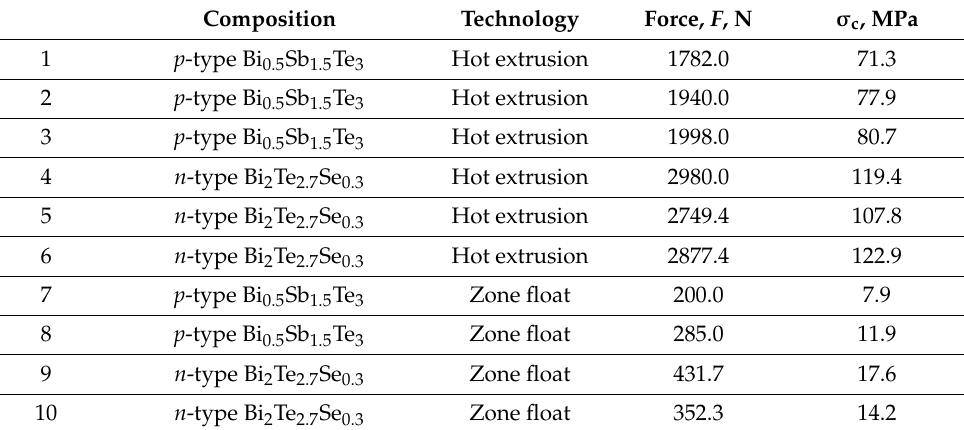
Table 2. The compression strength σ c of of Bi 2 Te 3 -based compound specimens preparedwith different